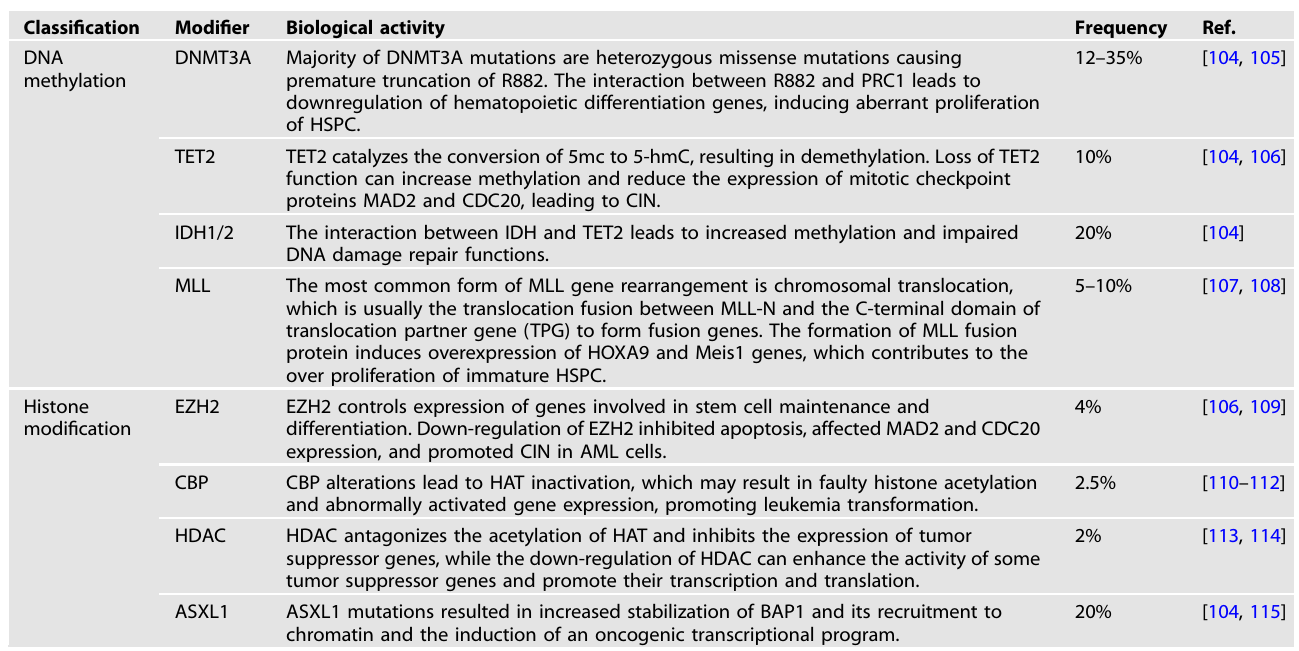
Table 1. Common epigenetic modi fi er mutations in